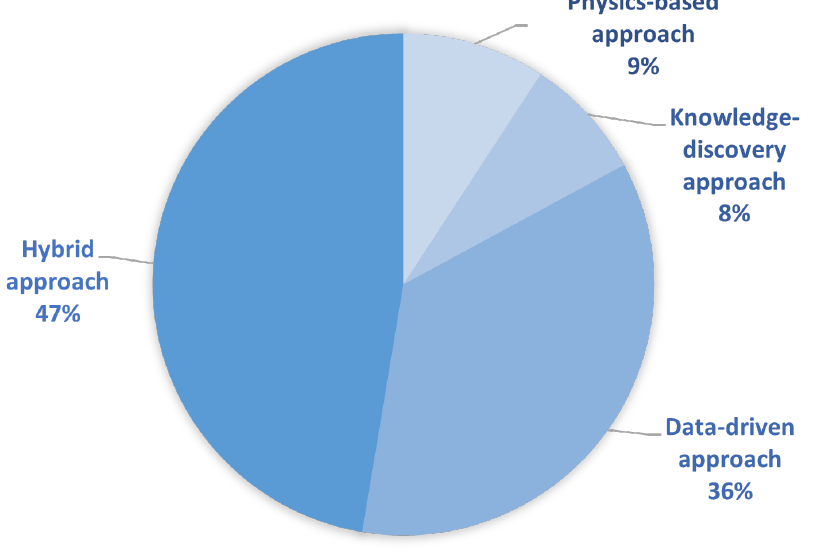
Figure 6. Overview of the selected literature grouped according to the proposed FDD